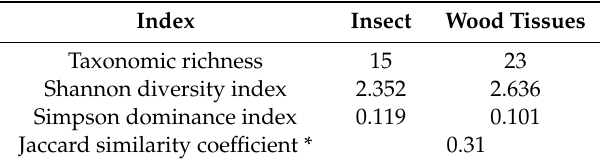
Table 5. Diversity indices of fungal communities.